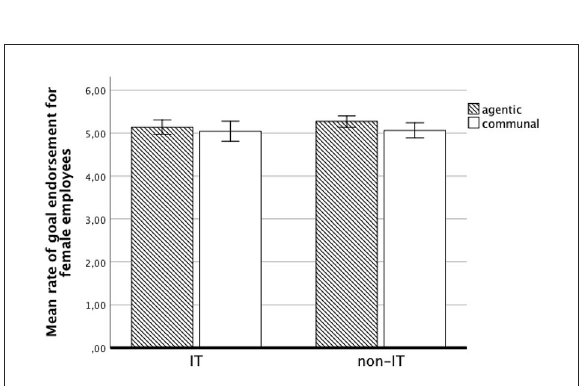
FIGURE2 Mean rate of goal endorsement for female